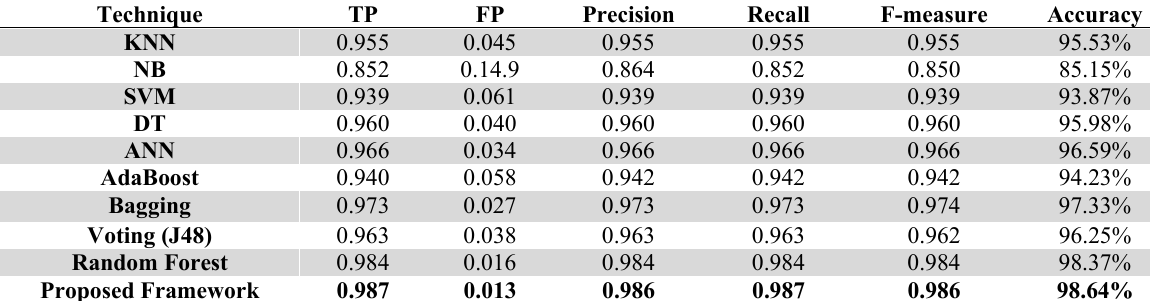
The Performance Results of the Ensemble